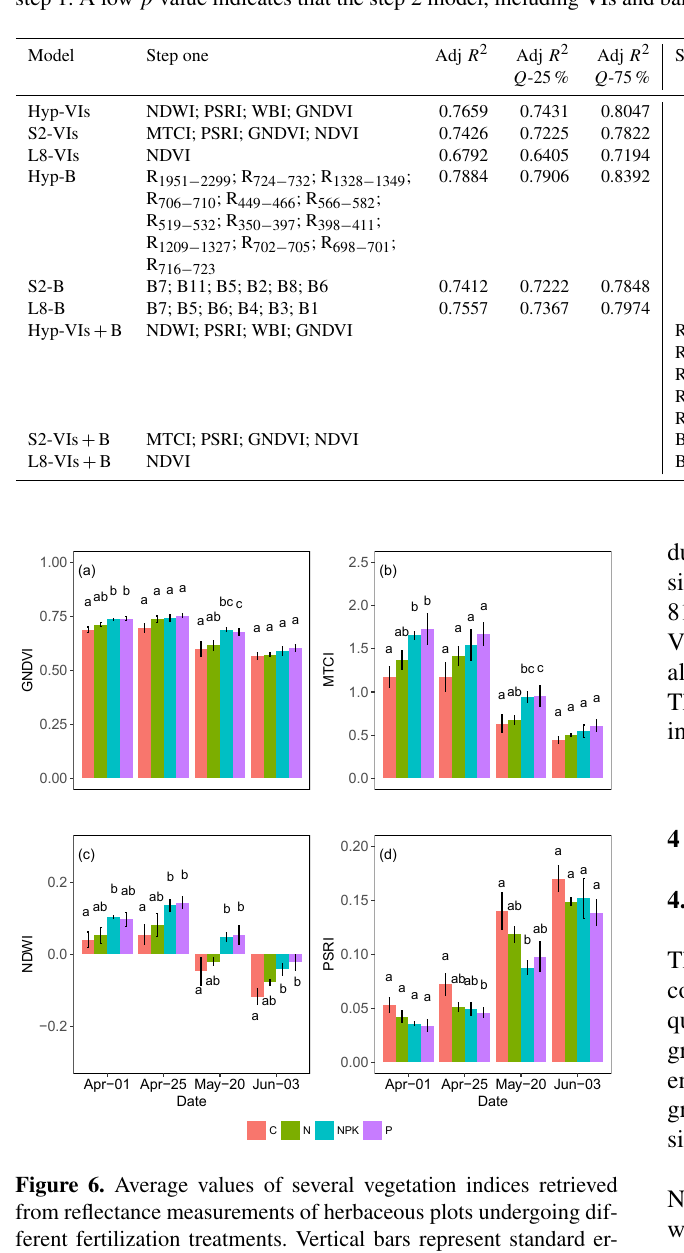
n P vj , where v is vegetation j, 1